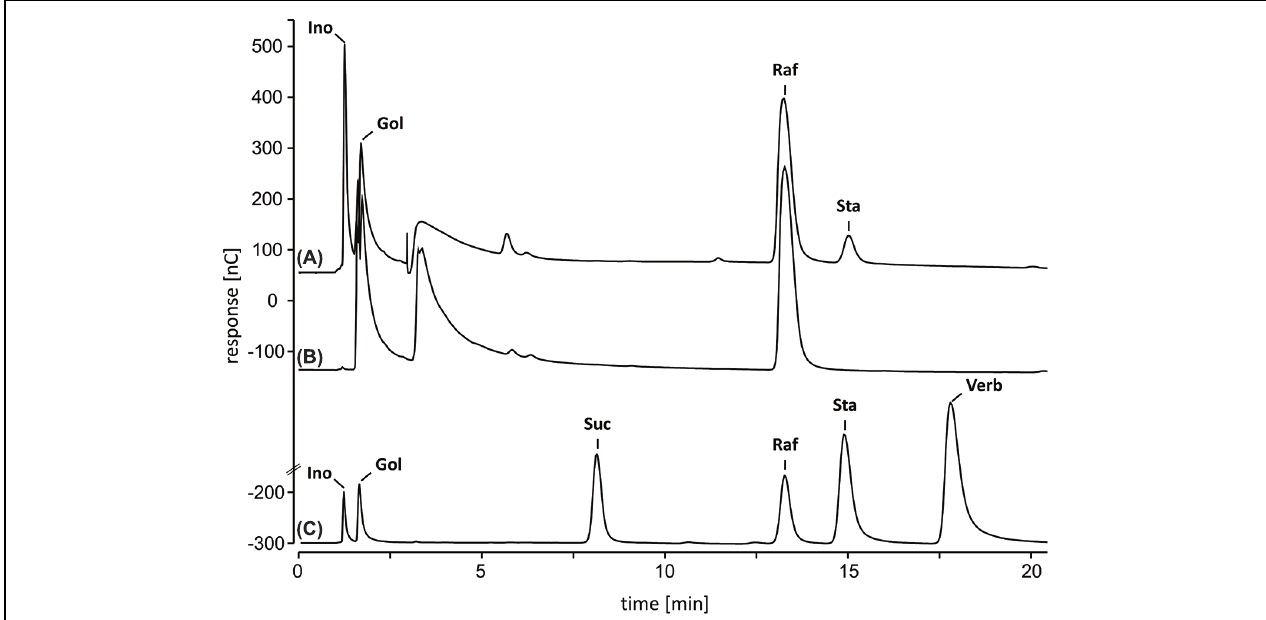
FIGURE 4 | High-performance anion-exchange chromatography with pulsed amperometric detection (HPAEC-PAD) enzyme assay. StaS enzyme activity of recombinant AtRS4 was tested. HPAEC-PAD chromatogram (A) indicates Sta product formation during enzyme reaction. HPAEC-PAD chromatogram (B) shows control without recombinant AtRS4. HPAEC-PAD chromatogram (C) shows 100 μ M Ino, Gol, Suc, Raf, Sta, and Verb as reference